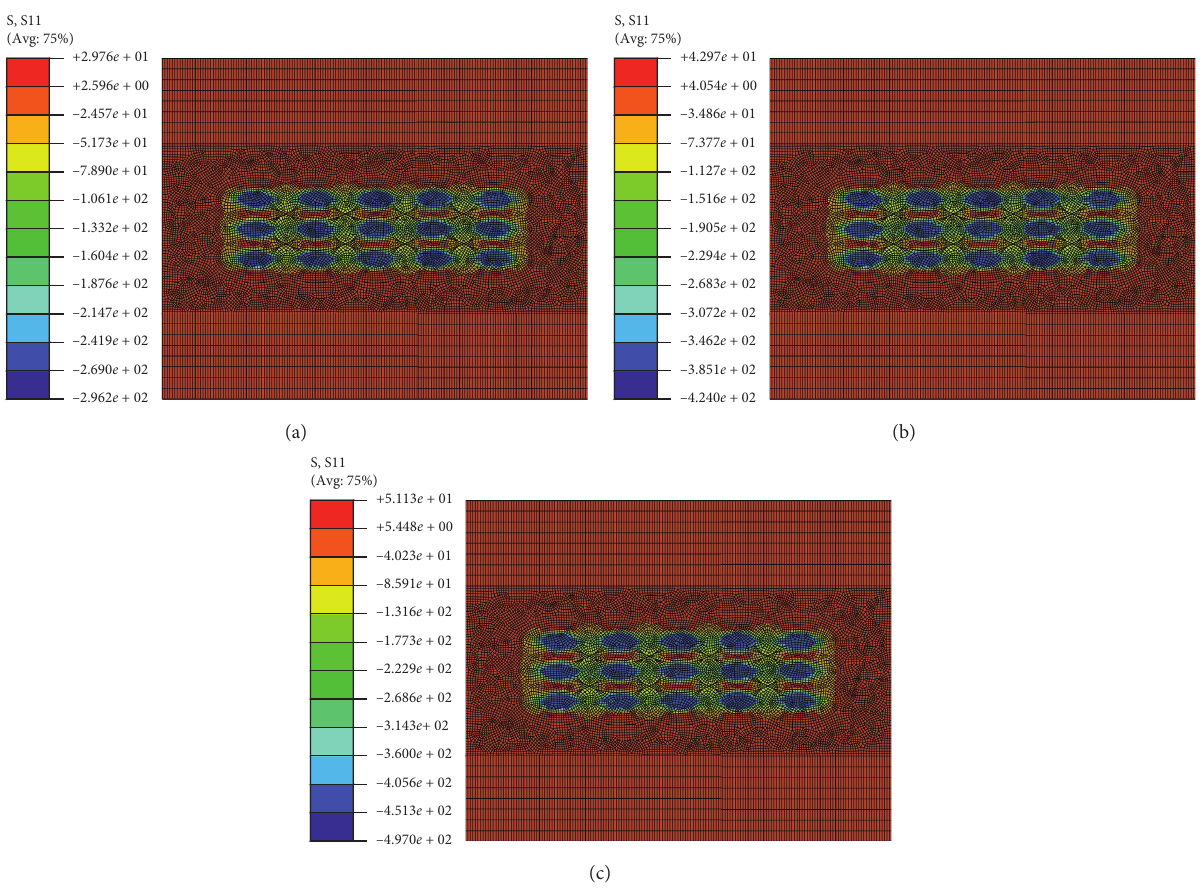
Figure 10: Contours of residual stress distribution of sample surface with different number of shocks. (a) 1 shock, (b) 2 shocks, and (c) 3 shocks.